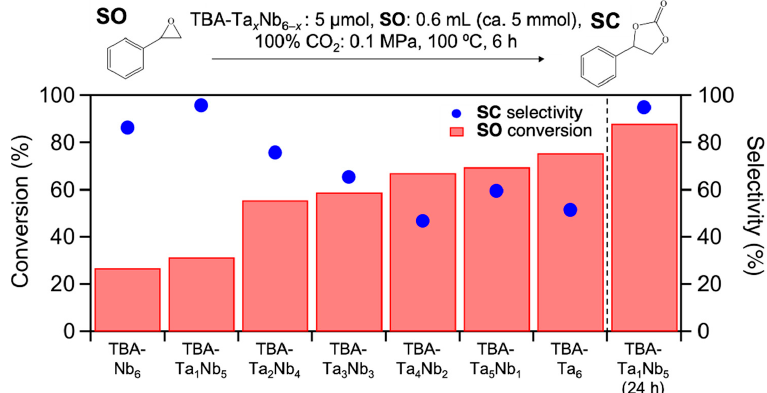
Figure 2. Results of CO 2 fixation to styrene oxide over TBA-Ta x Nb 6 − x . Bars represent conversion of SO , blue dots represent selectivity of SC . Reaction condition: catalyst loading = 5 µmol, SO = 0.6 mL (ca. 5 mmol), 100% CO 2 = 0.1 MPa, temperature = 100 ° C, reaction time = 6 h.